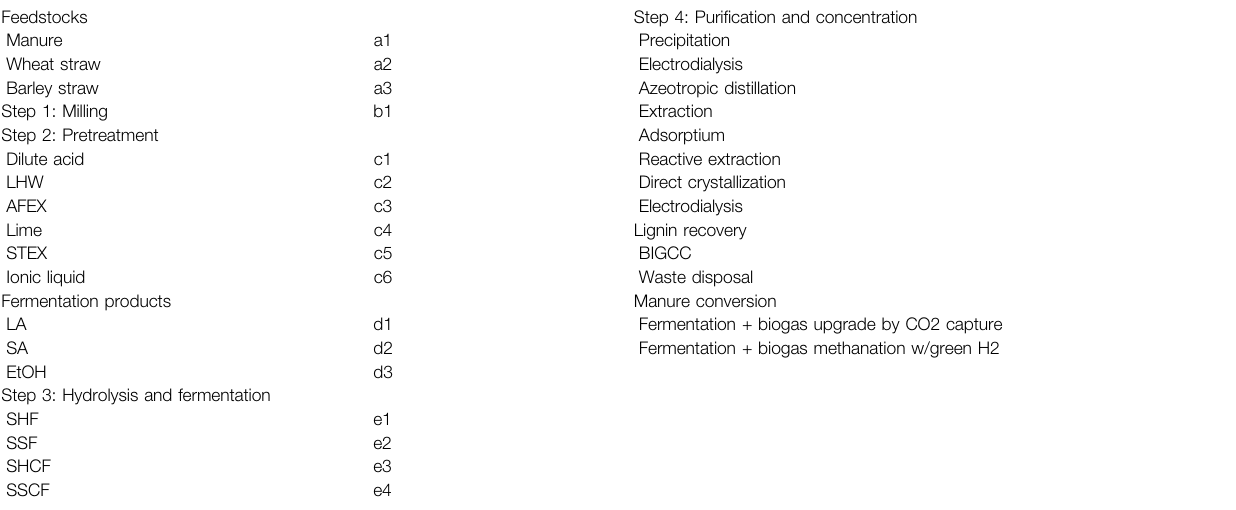
TABLE 1 | Codes used to describe the solutions presented in Table 1 and Figure 6 . Feedstocks